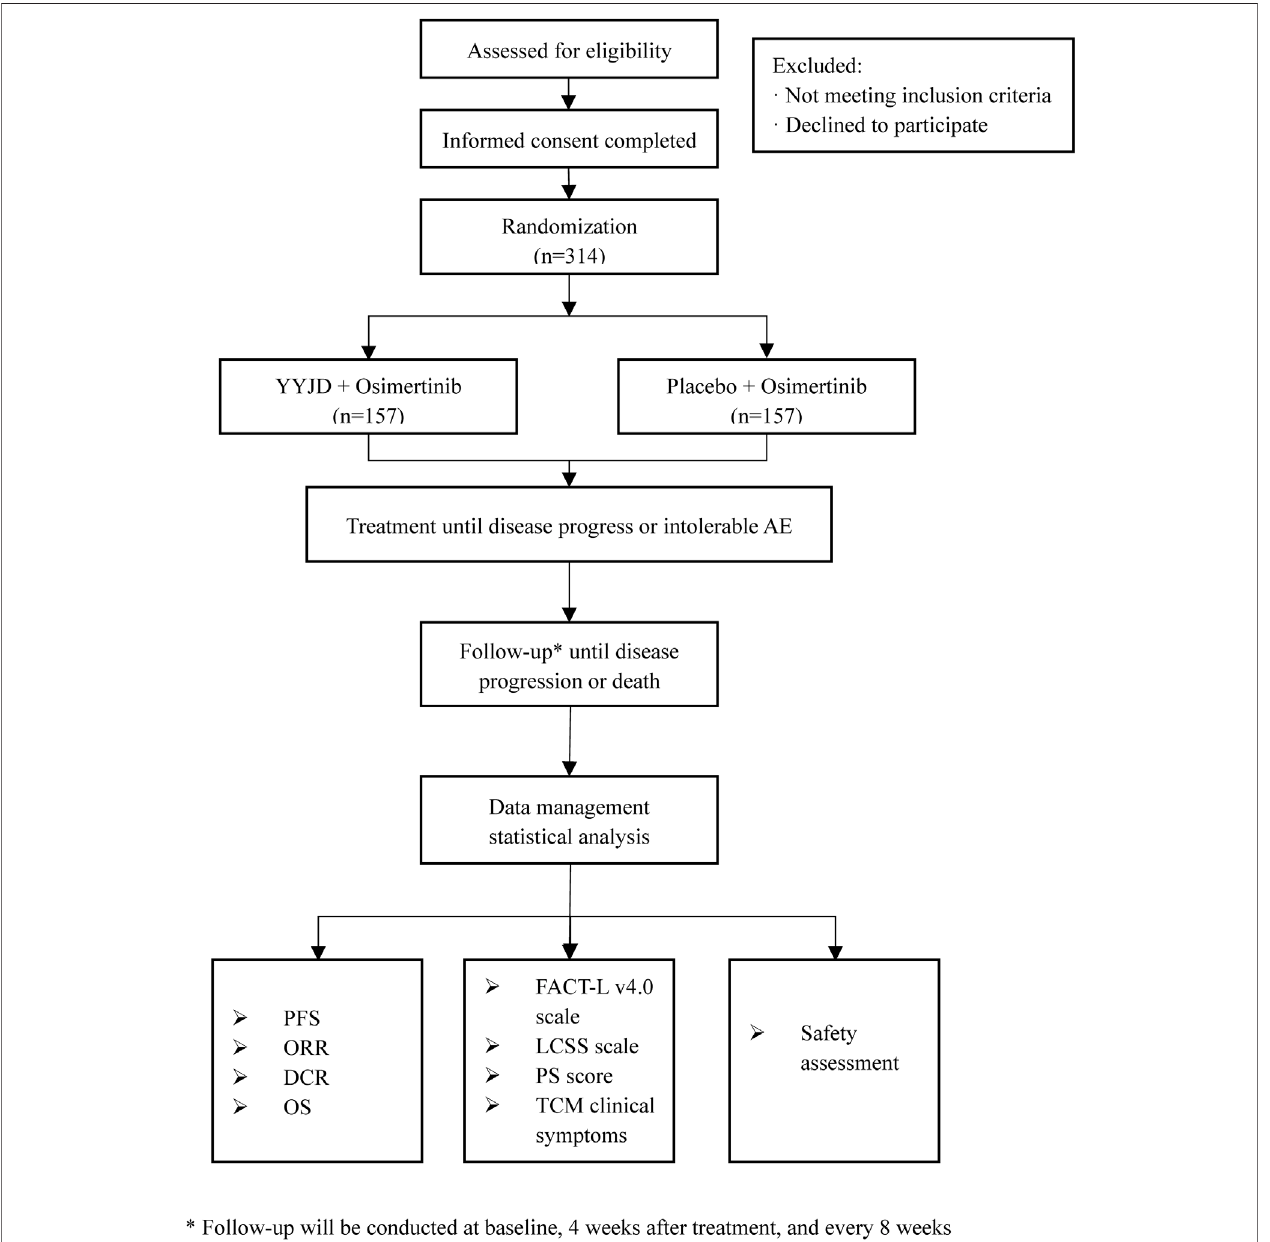
FIGURE 1 | The fl ow diagram of the